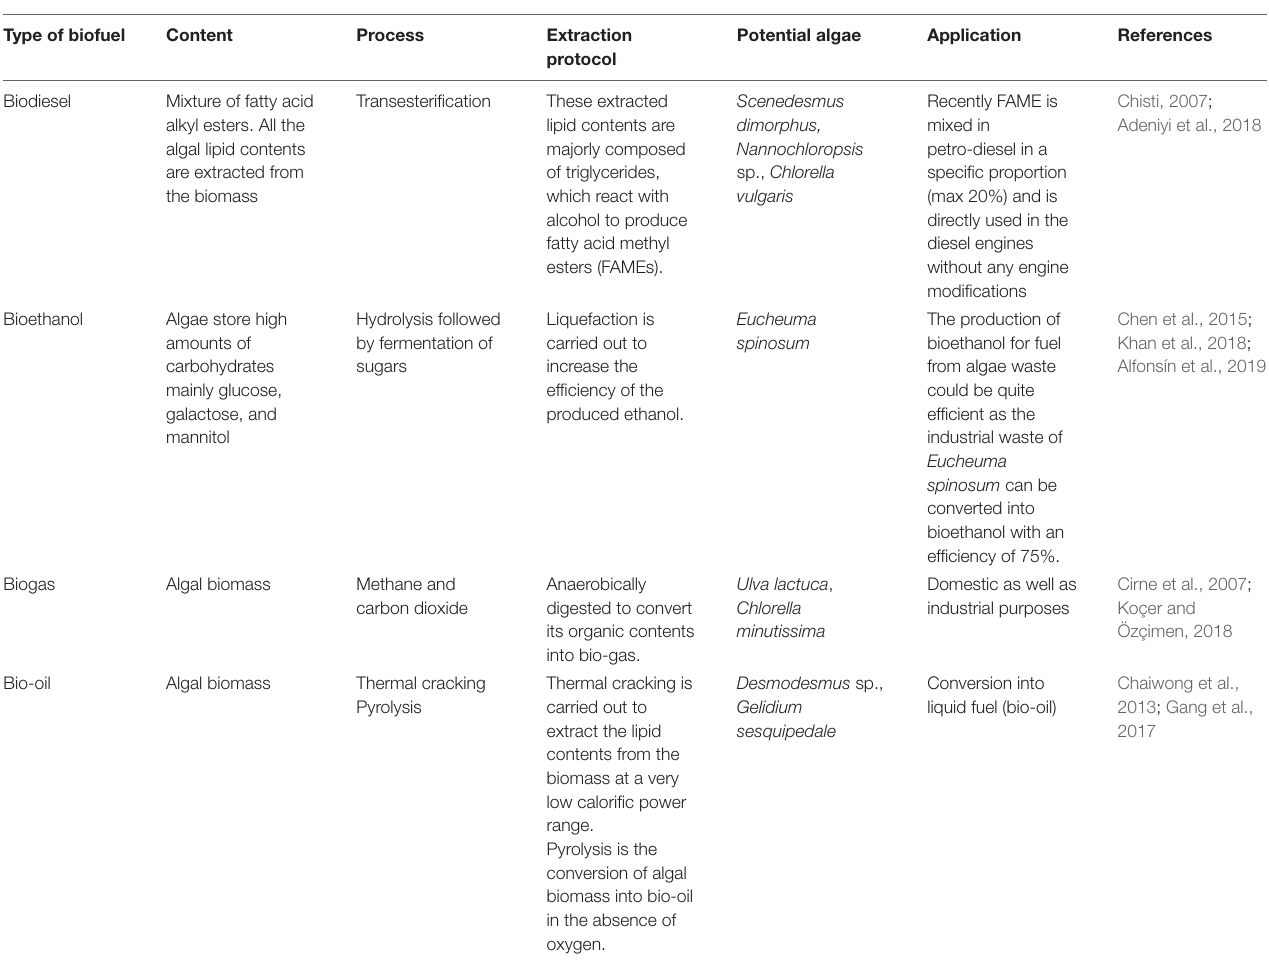
TABLE 2 | The main algal biofuels and their